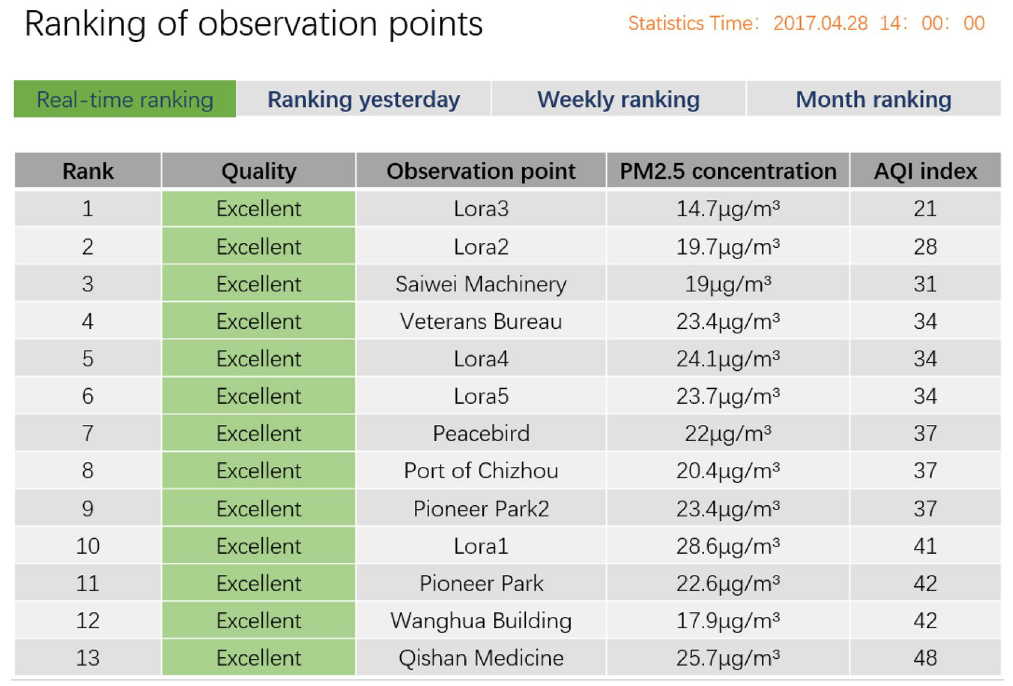
Figure 8. Application module: Ranking of observation points.